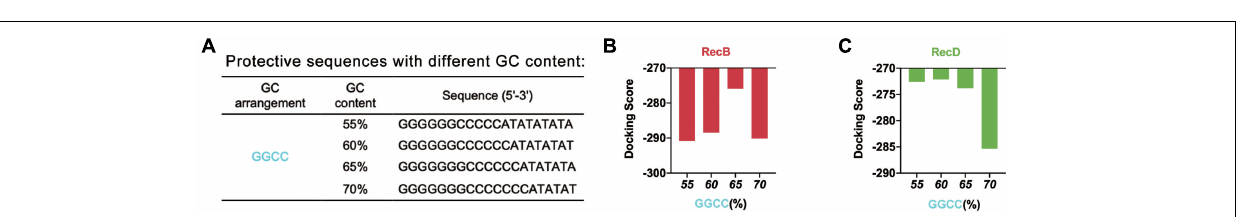
FIGURE 3 | Simulation results of protective sequences with different GC contents. (A) Protective sequences with different GC contents. GC contents included 55, 60, 65, and 70%. The length of protective sequences was 20 bp. (B) Simulation results of RecB subunit with different protective sequences. These protective sequences were GGCC arrangement mode and had different GC contents. (C) Simulation results of RecD subunit with different protective sequences. These protective sequences were GGCC arrangement mode and had different GC contents.